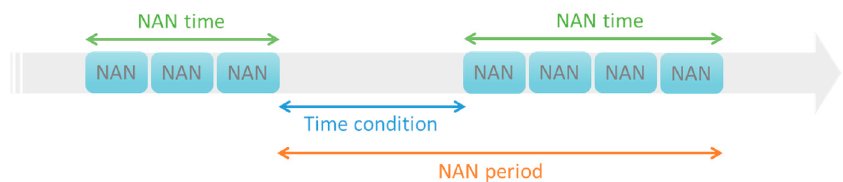
Figure 2. Recorded maintenance time data.